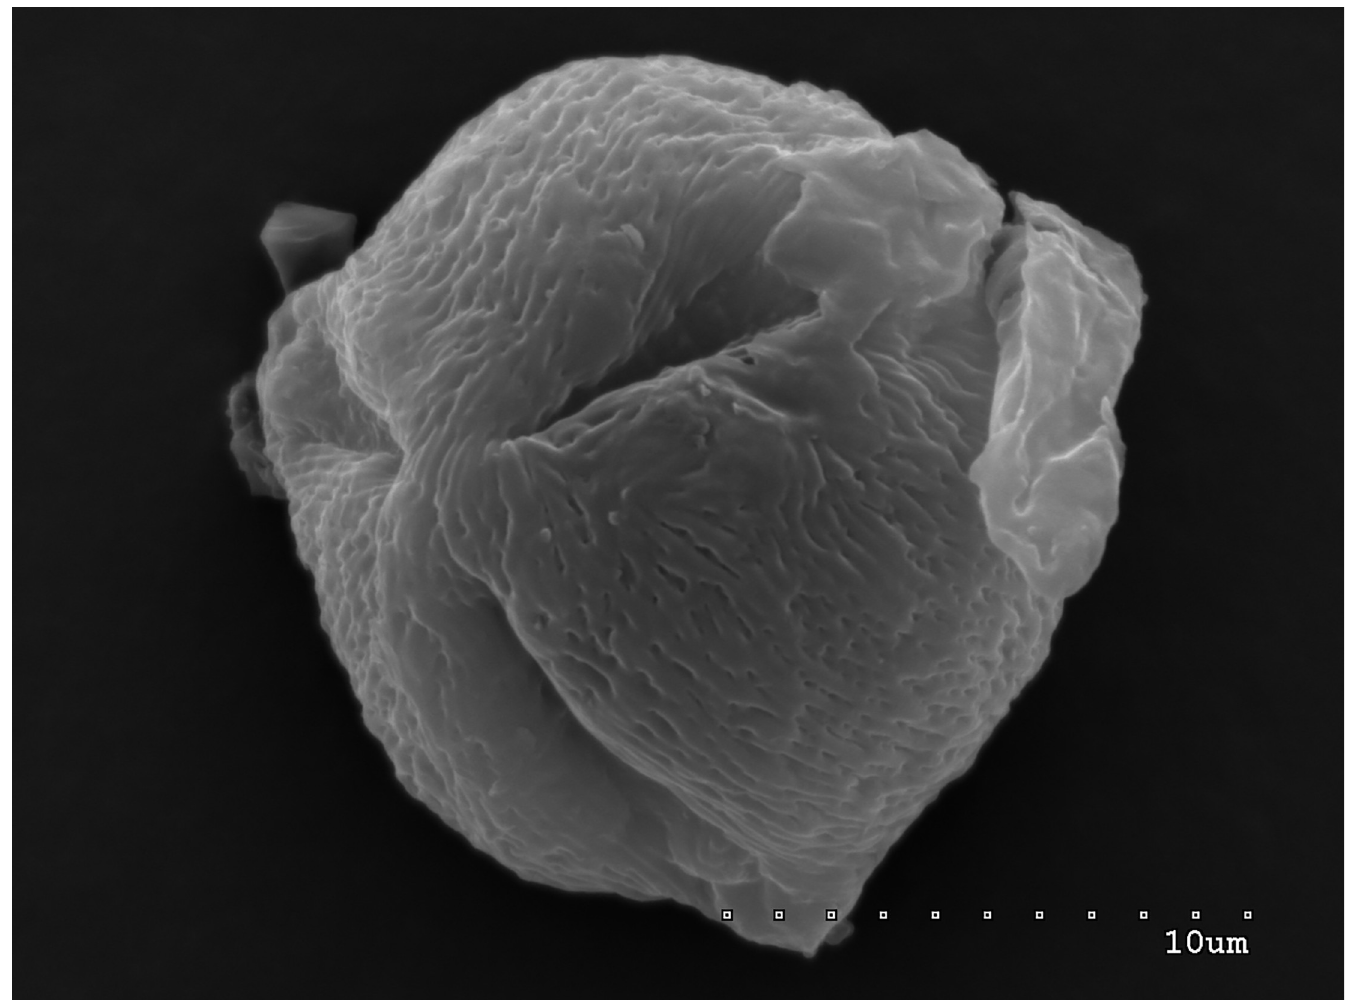
Fig 3. Pollen grain in polar view with three narrow colpori; striate exine ornamentation with striae and muri visible.